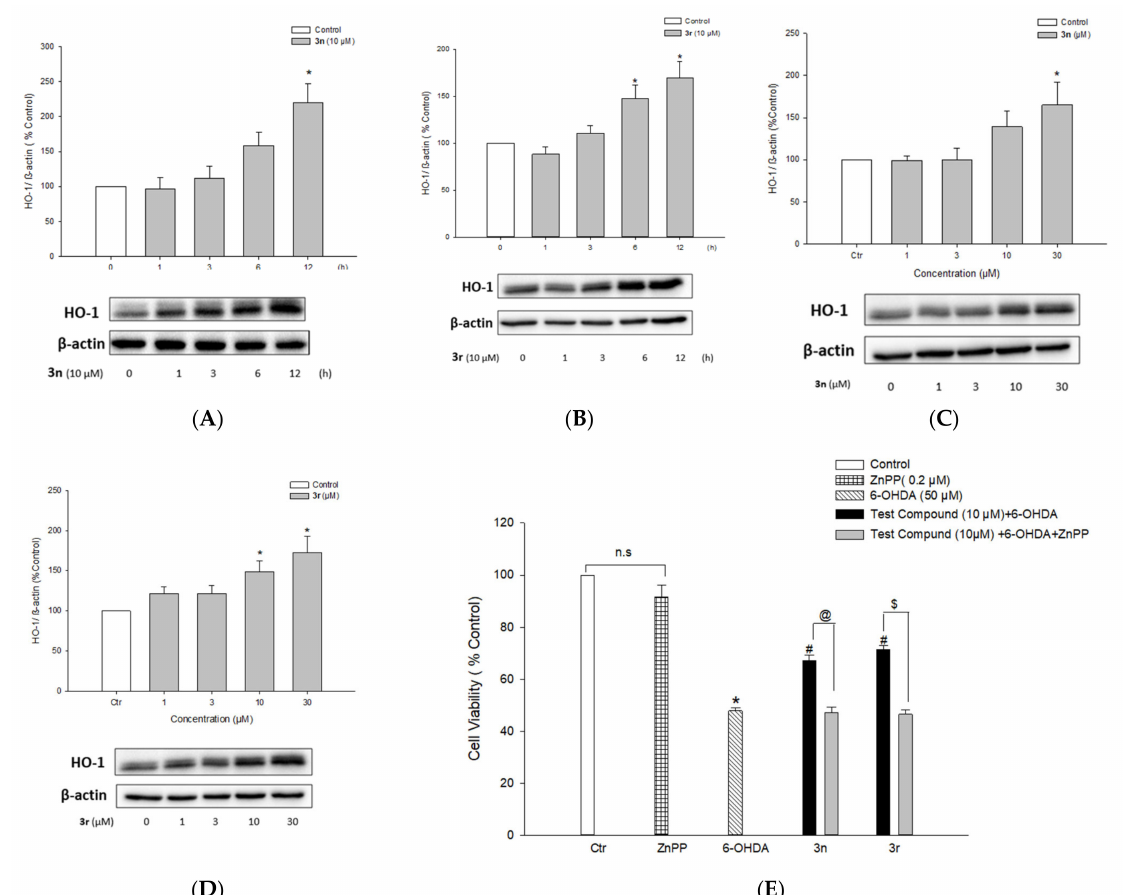
Figure 15. Up-regulation of HO-1 expression by compounds 3n and 3r and its role in neuroprotective effects. ( A – D ) PC12 cells were treated with compound 3n ( A ) or 3r ( B ) at 10 µ M for the indicated periods of time or the cells were treated with a series of concentrations of compound 3n ( C ) or 3r ( D ) for 12 h. The HO-1 protein expression was evaluated by Western blotting as described in the Materials and Methods section. Band intensity was quantified by densitometric analyses and normalized to β -actin. ( E ) PC12 cells pre-treated with 0.2 µ M ZnPP for 30 min were exposed to the test compounds for 4 h, which was followed by incubation with 6-OHDA at the final concentration of 50 µ M for an additional 24 h. Cell viability was assessed by MTT reduction assay. Each data point represents the mean ± SEM from at least three measurements performed in duplicate (Ctr, control, * p < 0.05 vs. the vehicle-treated control cells; # p < 0.05 vs. 6-OHDA-treated cells; @ p < 0.05 vs. the cells treated with compound 3n and 6-OHDA without ZnPP; $ p < 0.05 vs. the cells treated with compound 3r and 6-OHDA without ZnPP; n.s., not significant). 6-OHDA,